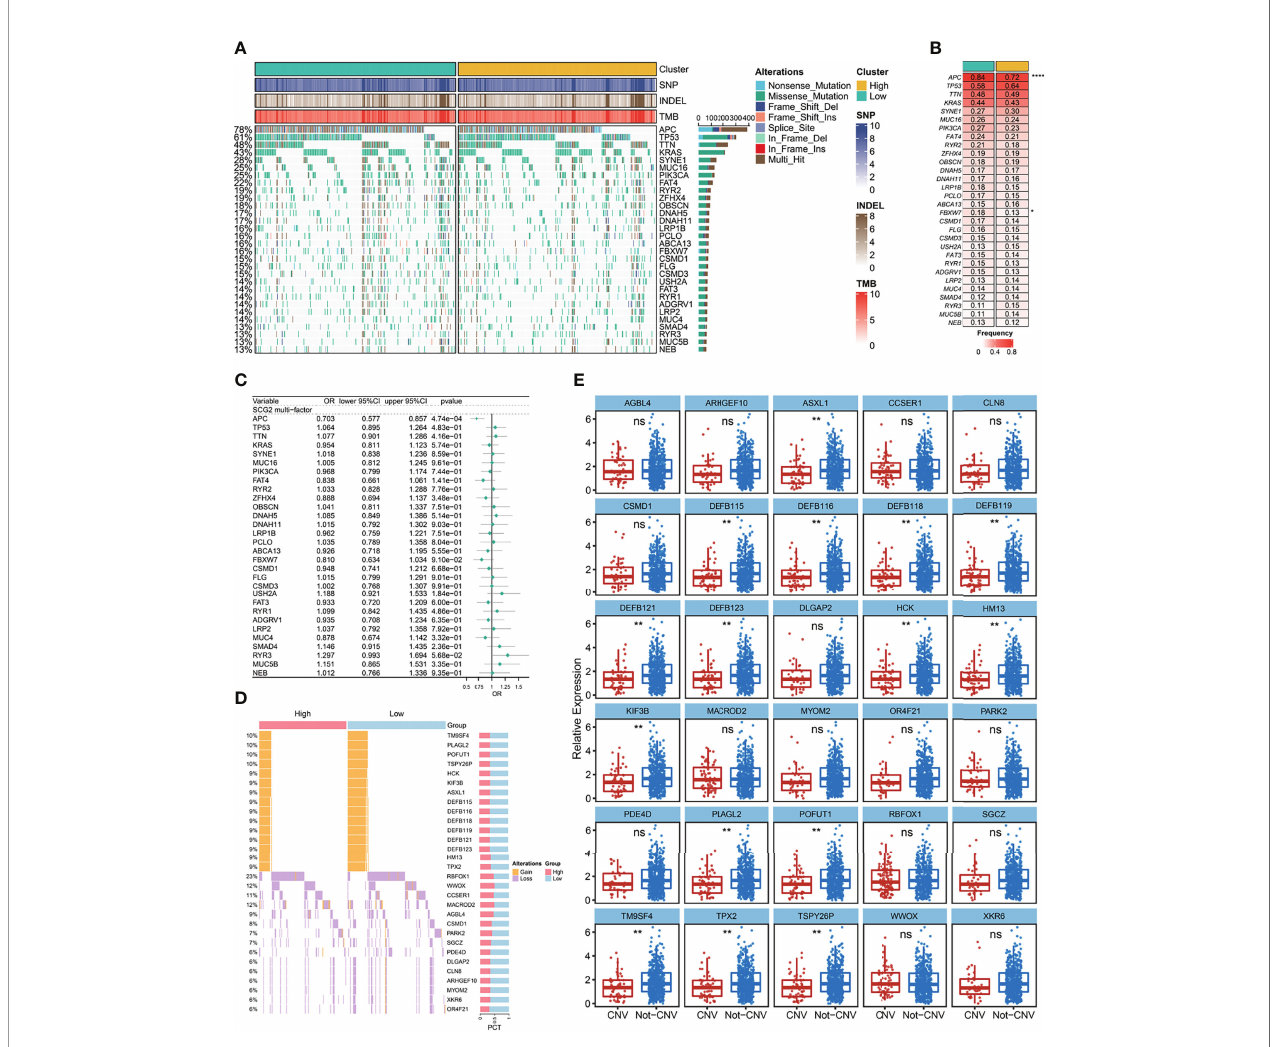
FIGURE 7 | Gene mutation and copy number variation analysis. (A) Mutation landscape between high and low expression groups of SCG2, including a total of 30 frequently mutated genes (FMGs). (B) Analysis of mutational differences in FMGs between SCG2 expression subgroups. (C) A multivariate logistic regression analysis of FMGs, which incorporated SCG2 expression, TMB, age, gender, and stage. (D) Copy number variation landscape between high and low expression groups of SCG2. (E) Expression differences of SCG2 between variant and non-variant groups in top 15 deletion and ampli fi cation genes of copy number variation. * P <0.05; ** P <0.01; **** P <0.0001; ns, P